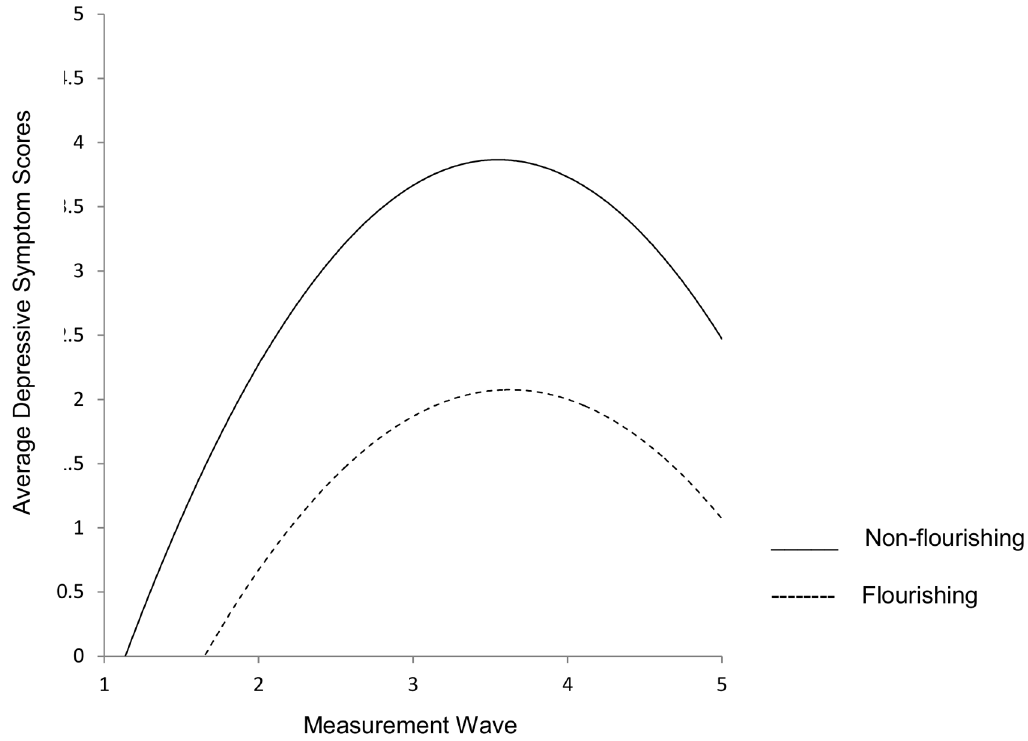
Figure 3. Growth curves of effects of flourishing and non-flourishing status on depressive symptoms.